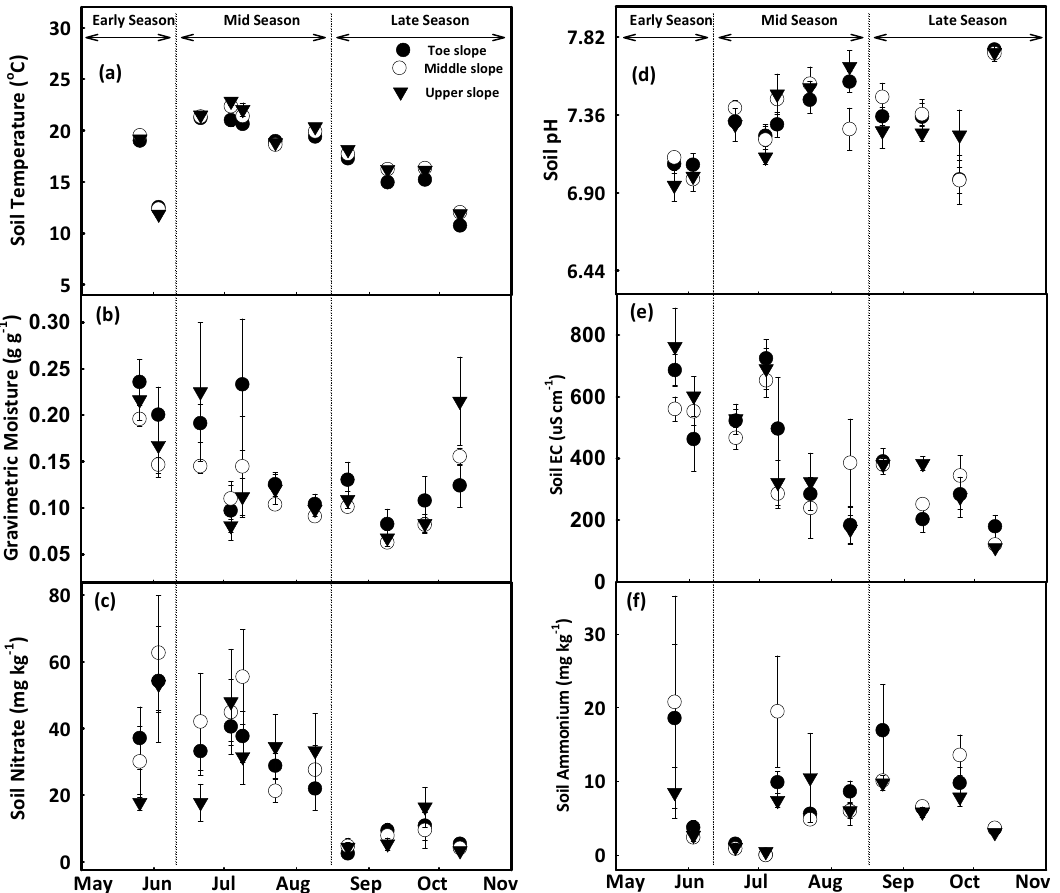
Figure 2. Temporal changes in soil temperature ( a ), gravimetric moisture content ( b ), nitrate ( c ), pH ( d ), electrical conduc- tivity ( e ) and ammonium concentration ( f ) at Baggs farm. Scatter plots were prepared using mean values (Mean ± SEM) from four replications at each slope positions. Soil samples were collected during early season (26 May, 3 June), mid season (21 June, 4 July, 9 July, 23 July, 9 August) and late growing season (23 August, 9 September, 25 September, 10 October).